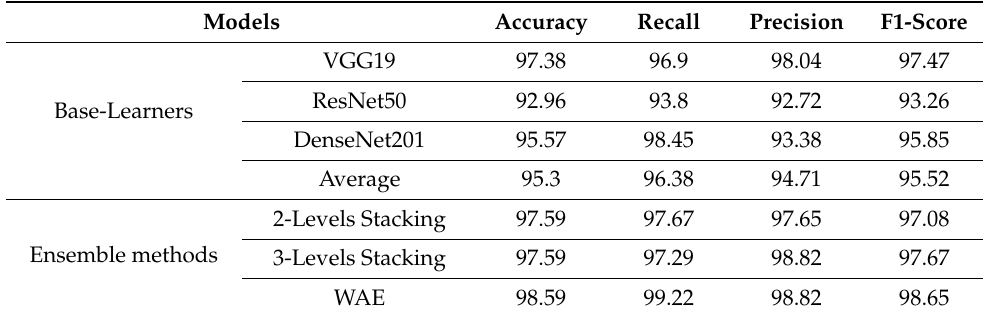
Table 7. Comparison among the proposed ensemble methods and the Base-Learners on the SARS- CoV-2 CT-scan dataset [42].